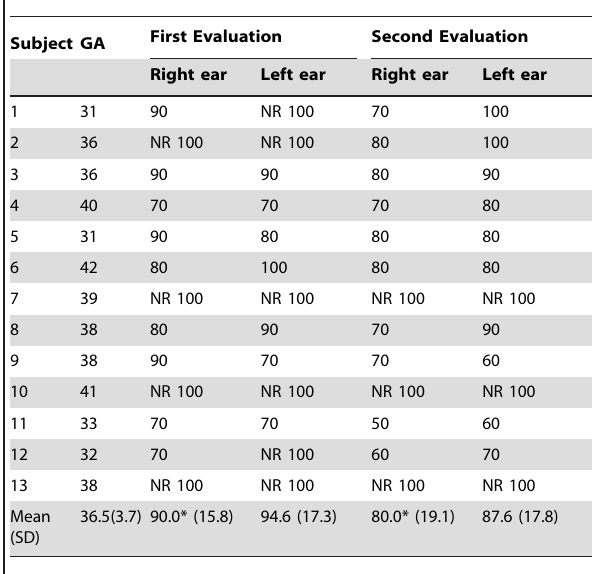
Table 2. Auditory Brain Responses (Hearing